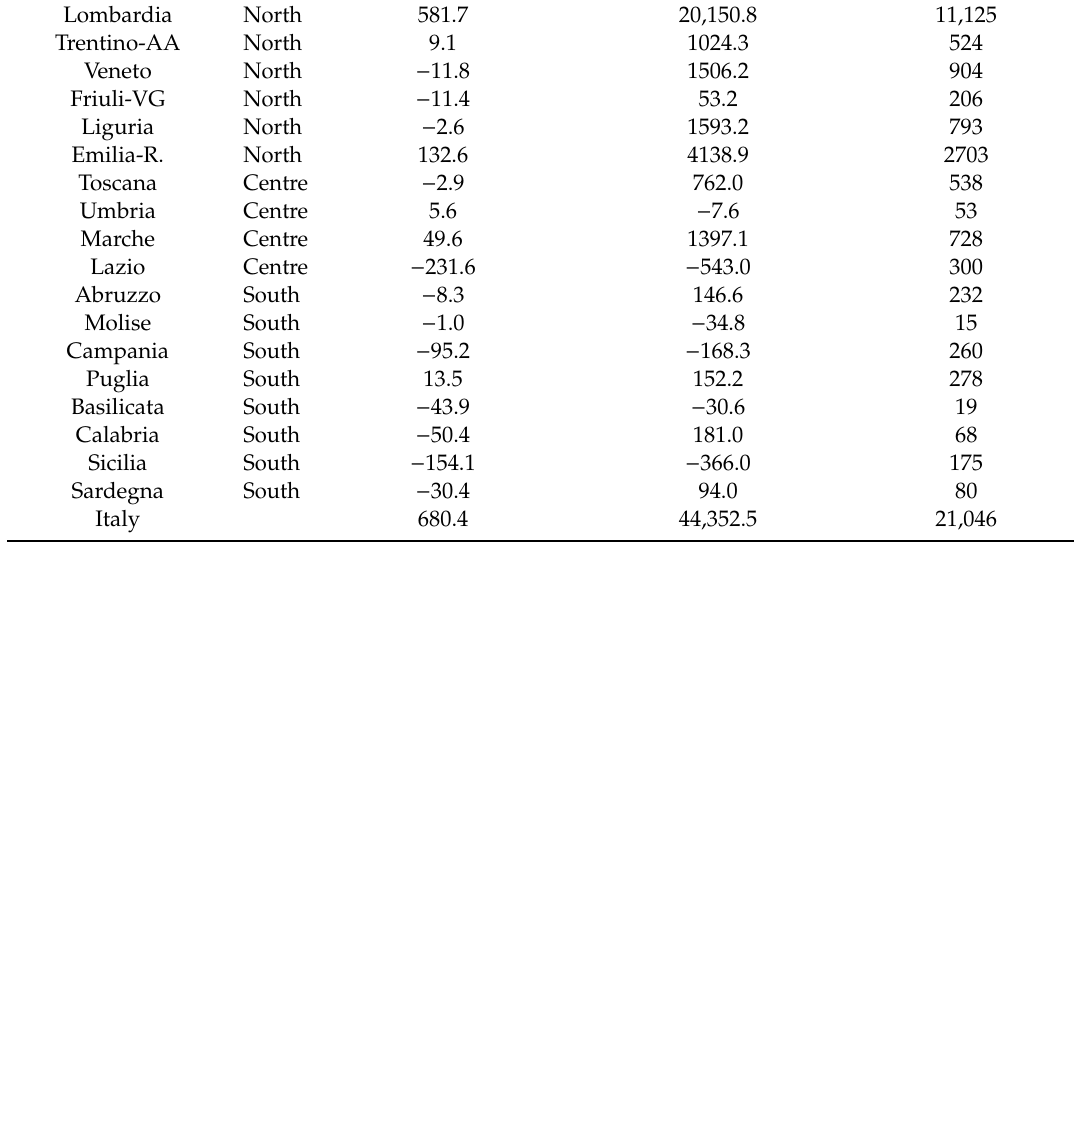
Table 4. Estimated excess deaths from March 1st to April 15th, 2020 in the total population, by region. Estimated Excess Deaths in the Total Population Deaths Attributed Area Age < 60 Age ≥